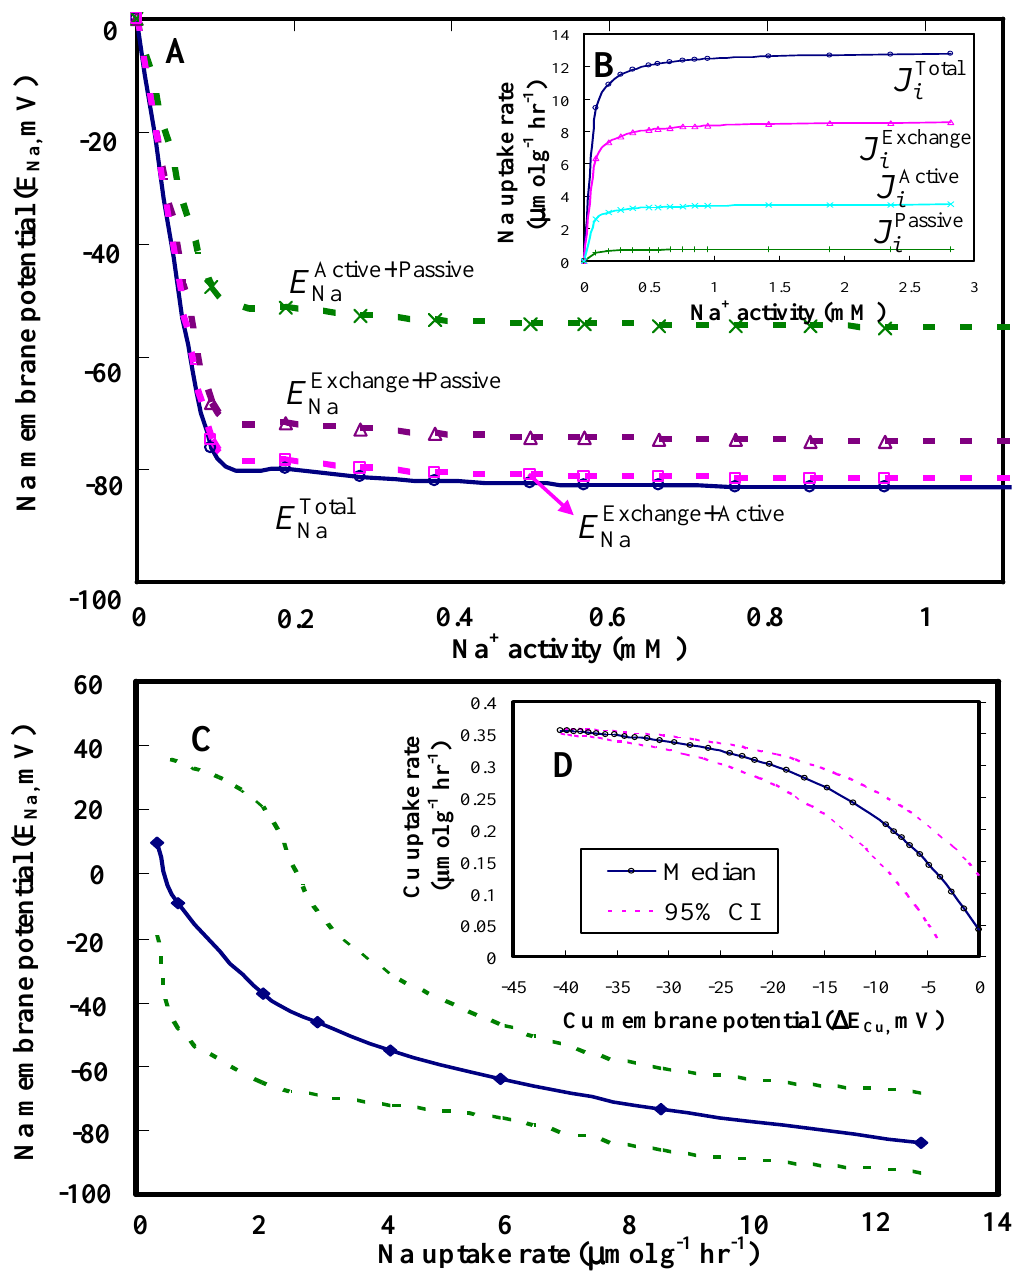
Figure 3. Physiological and electrophysiological kinetics of Na flux partitions: (A) Na membrane potentials and (B) the unidirectional Na influx. Predicted the profiles of ion uptake rate - Nernst membrane potentials for (C) Na and (D)